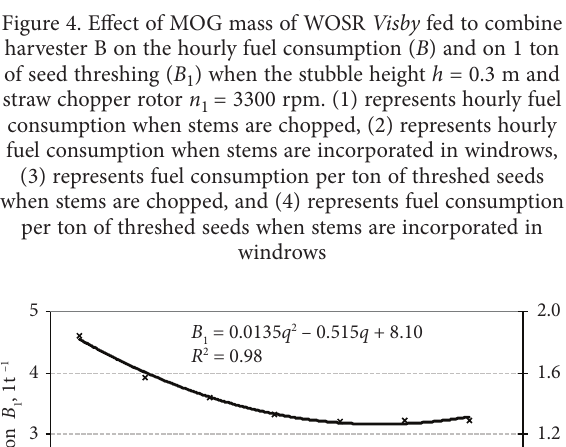
B = 0.0135 q 2 – 0.515 q + 8.10 1 R 2 =